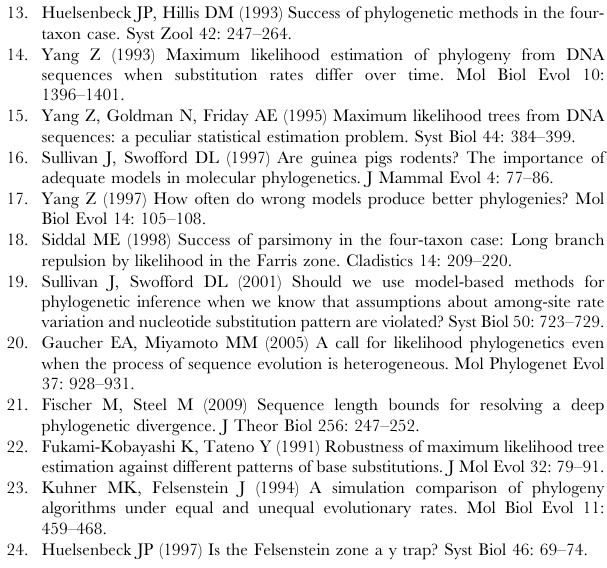
Figure S1 ML reconstruction success of simulated paramter and branch length settings. Figure S2 ML values of reconstructed topologies. Figure S3 ML parameter estimates of reconstructed topologies.